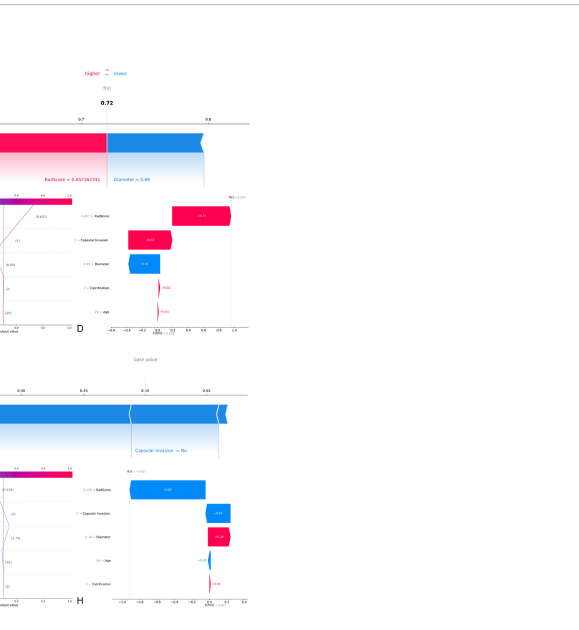
FIGURE 6 Two examples of correct prediction of CCLNM+ and CCLNM-. (A – D) A 28-year-old male patient was admitted to our hospital for further treatment after physical examination found a nodule in the right lobe of the thyroid. Ultrasound examination showed a nodule in the middle of the right lobe of the thyroid, 0.69 cm in diameter, with coarse calci fi cation and capsular invasion. Postoperative pathological fi ndings: papillary carcinoma of the right lobe of thyroid, with lymph node metastasis in the right central region. Retrospective analysis of the case showed that the radiomics score was 0.657 and the XGBoost model predicted CCLNM+ correctly. (E – H) A 44-year-old male patient was admitted to our hospital because or volume increase of the right thyroid lobe. Ultrasound examination showed a nodule in the middle of the right lobe of thyroid, 2.74 cm in diameter, with coarse calci fi cation and without capsular invasion. Postoperative pathological fi ndings: papillary carcinoma of the right lobe of thyroid, with no lymph node metastasis in the right central region. Retrospective analysis of the case showed that